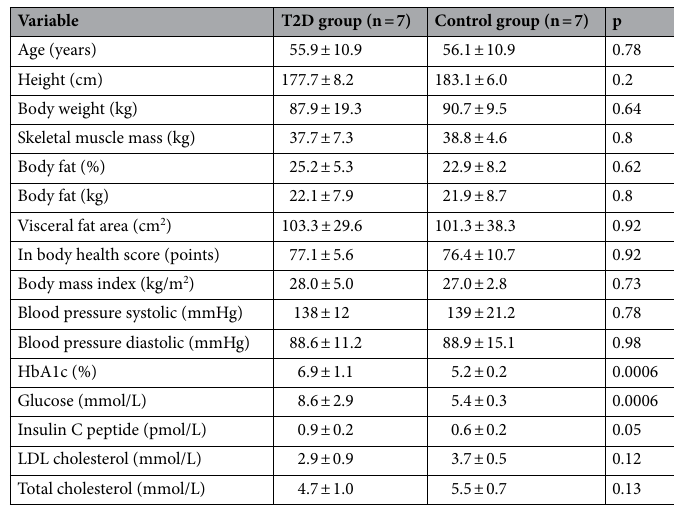
Table 1. Physical characteristics and baseline blood samples presented as mean ± standard deviation. LDL low-density lipoprotein, p p